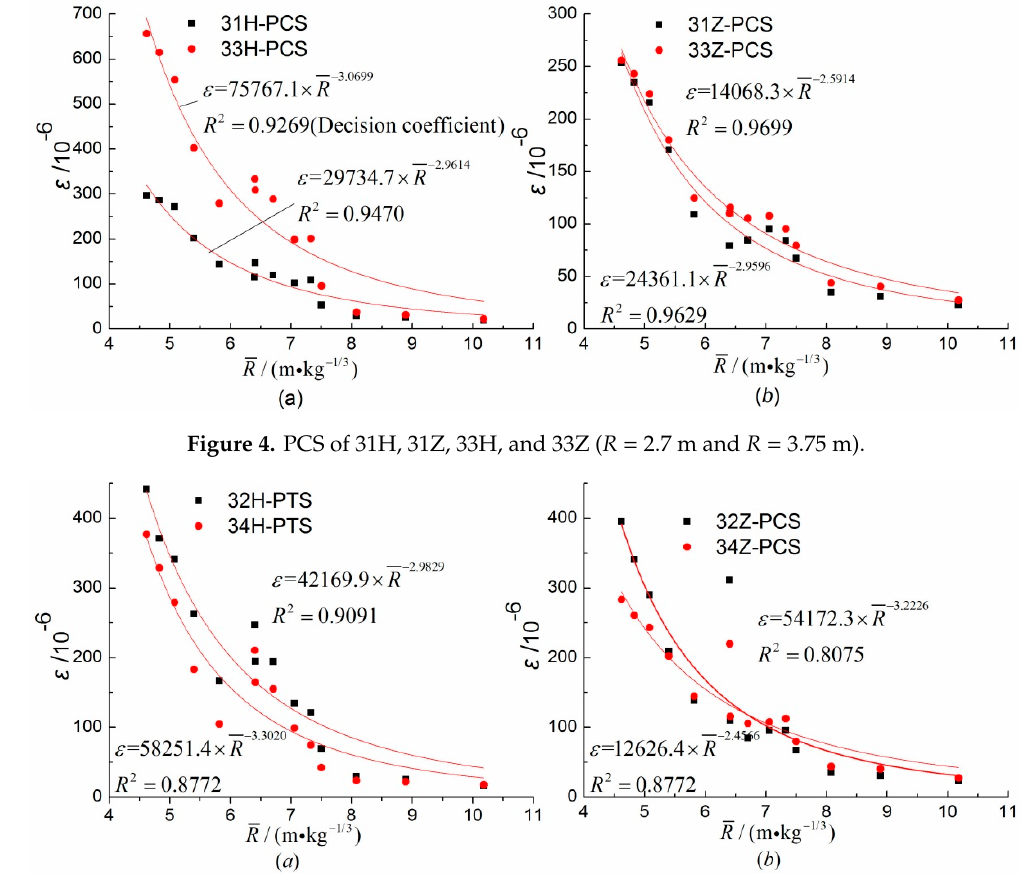
Figure 5. The peak strains of 32H, 32Z, 34H, and 34Z ( R = 2.7 m and R = 3.75 m).